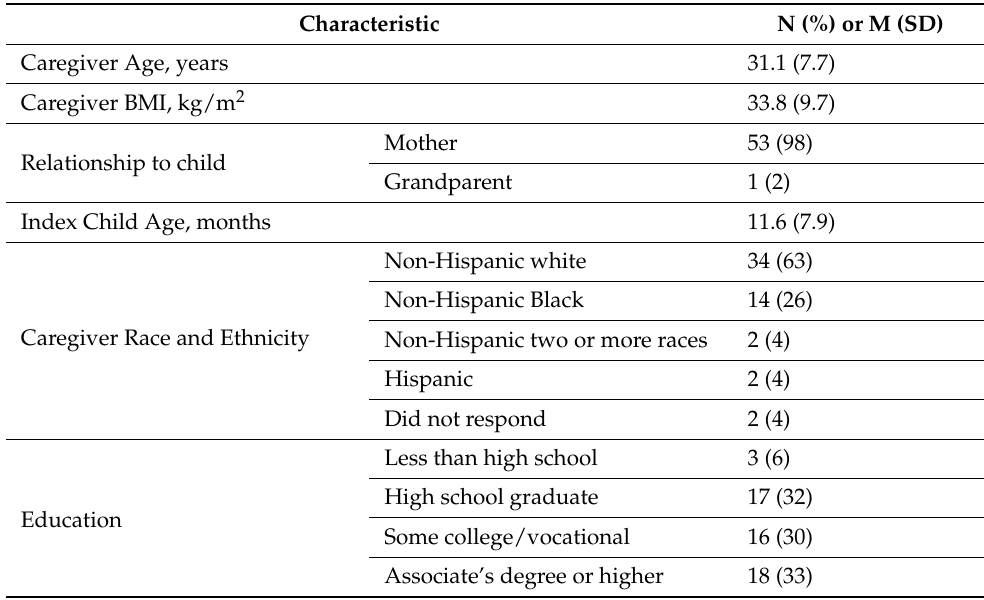
Table 2. Baseline demographic and psychosocial characteristics of parents and caregivers of young children participating in Healthy Roots (n =